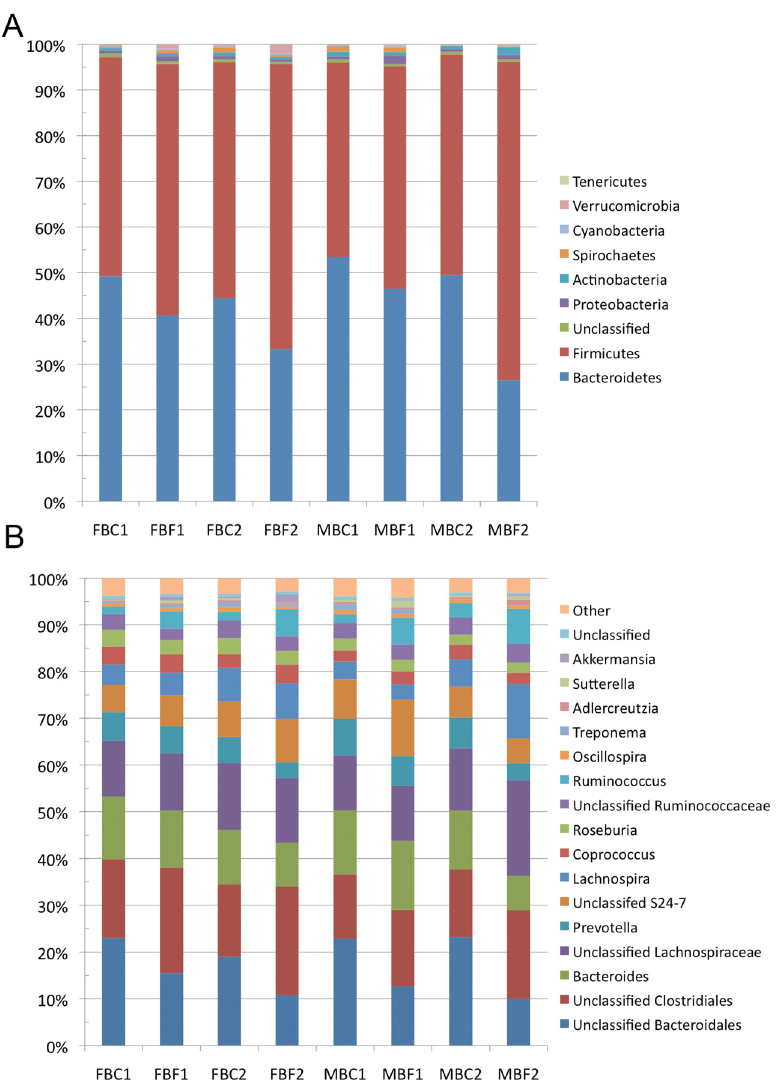
Fig 2. Taxonomic summary of 16S rRNA gene sequences from the ceacum and feaces of each beaver examined in this study. A) Relative abundance of sequences in the ceacum and feaces of each individual at the phylum level. B) Relative abundance of sequences in the ceacum and feaces of each individual at the genus level. Sequences present with < 0.5% relative abundance were pooled into a group labeled “ other ”